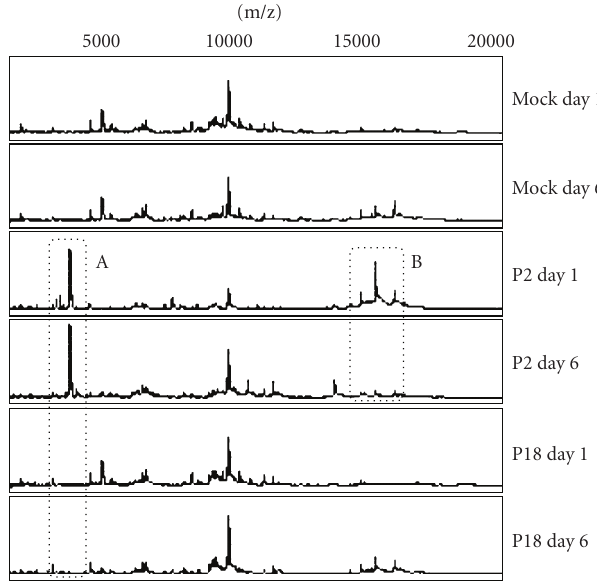
Figure 1: SELDI spectra reveal virus and time-based peak di ff er- ences. Guinea pigs were mock-infected or infected with the P2 or P18 variant of Pichinde virus . At 1 day and 6 days post infection, peritoneal cells were harvested and cytoplasmic and nuclear extracts prepared and analyzed using surface enhanced laser desorption ionization time-of-flight mass spectrometry. Experiments were performed in triplicate. Protein peaks were identified which showed patterns specific to type and stage of infection. The figure shows a representative set of spectra from cytoplasmic